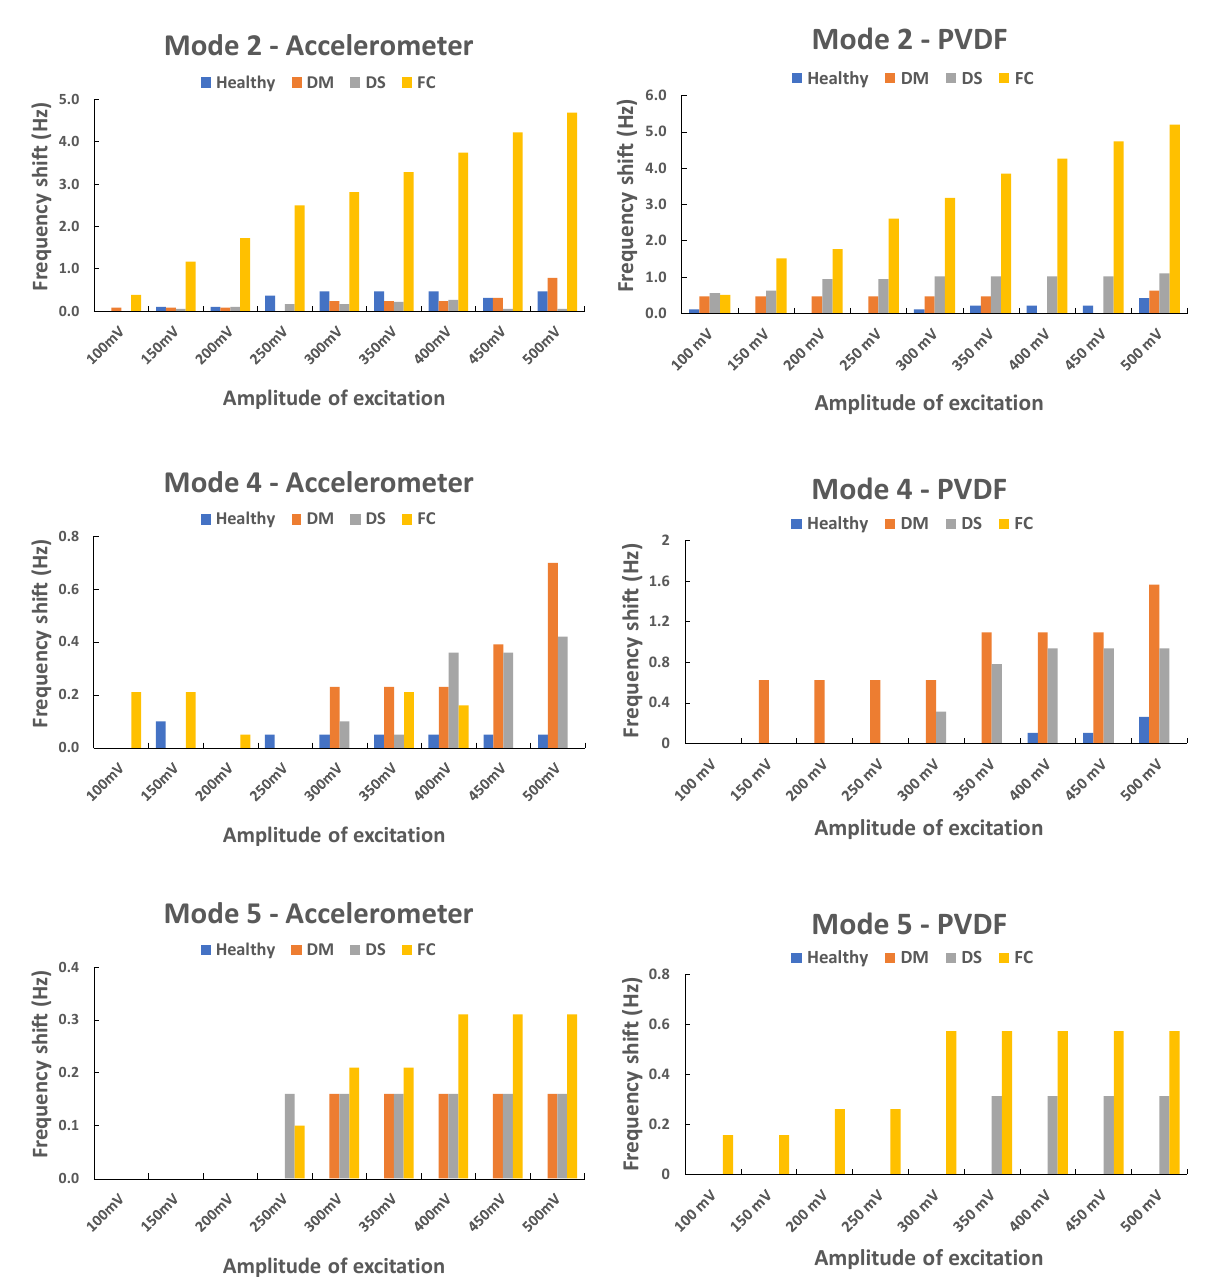
Figure 10. Frequency shift vs. amplitude of excitation: second, fourth, and fifth natural